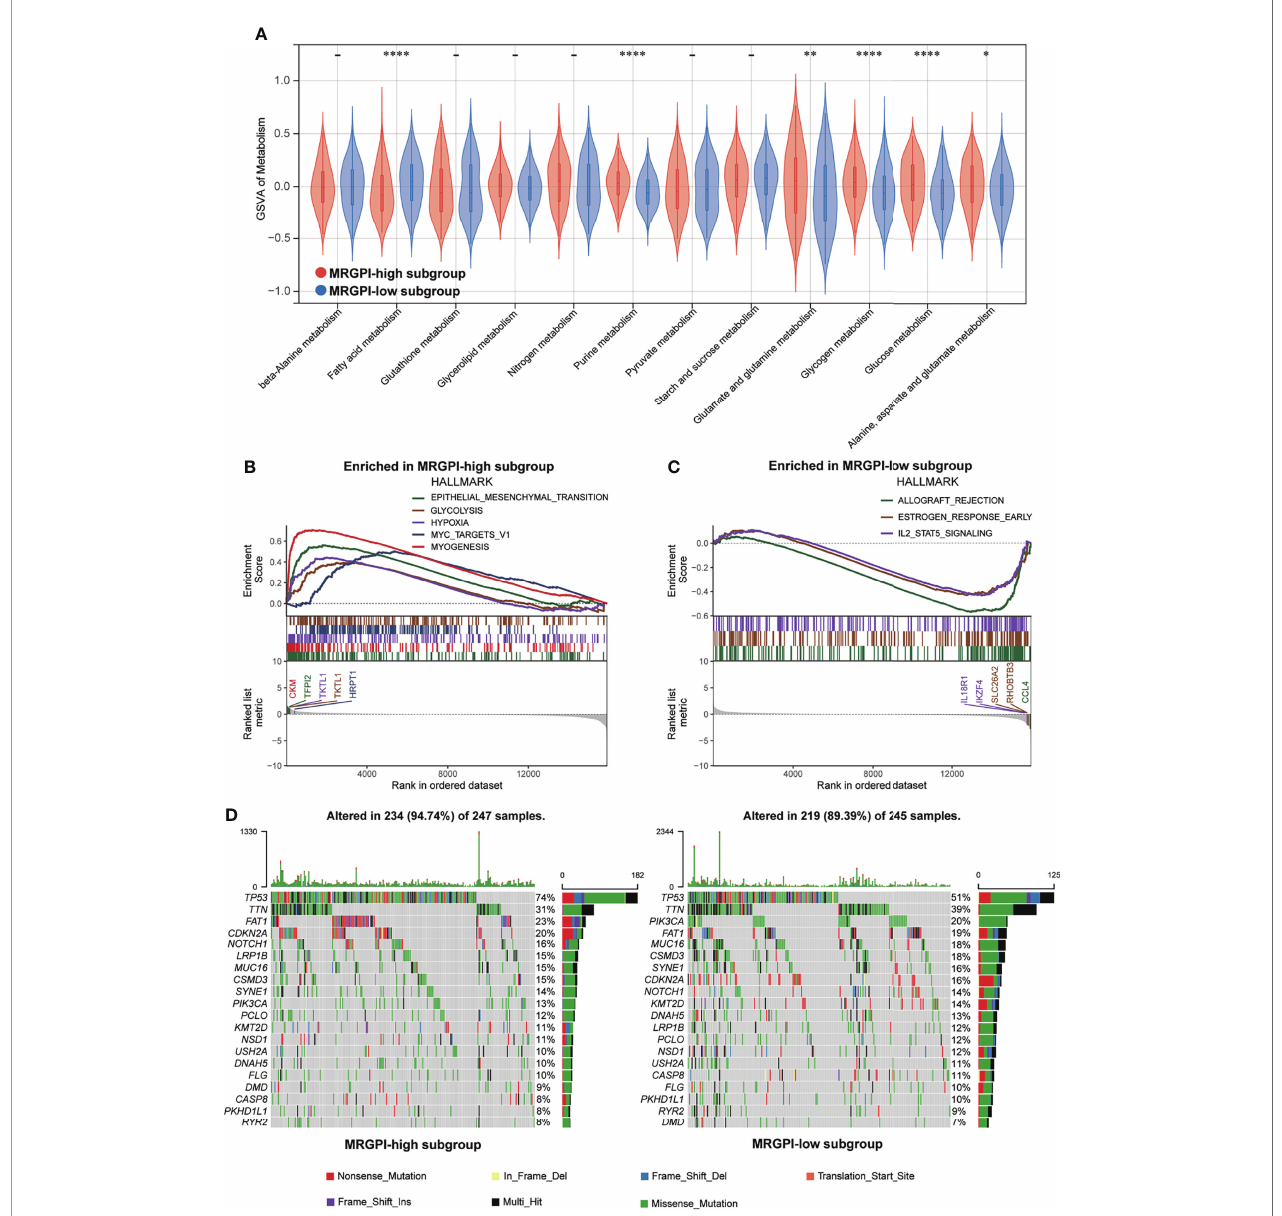
FIGURE 2 | Metabolic activities and molecular characteristics of the different MRGPI subgroups. (A) The scores of common metabolic pathways of the different MRGPI subgroups. (B) Hallmark gene sets enriched in the high-MRGPI subgroup (p < 0.05, FDR <0.25). (C) Hallmark gene sets enriched in the low-MRGPI subgroup (p < 0.05, FDR <0.25). (D) Top 20 mutated genes in the different MRGPI subgroups. Mutated genes (rows) are ordered by mutation rate; samples (columns) are arranged to emphasize mutual exclusivity among mutations. The rightmost label shows mutation percentage, and the top shows the overall mutation number of the patients. The colored squares indicate the mutation type. *P < 0.05,**P < 0.01,****P < 0.0001. MRGPI, metabolism-related gene prognostic index; FDR, false discovery